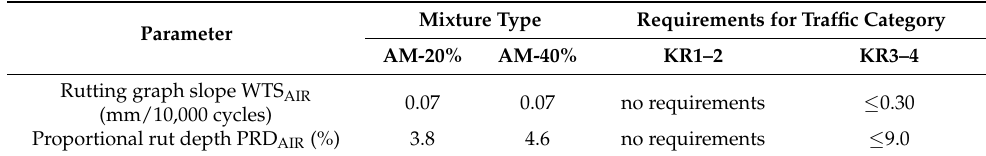
Table 6. The test results of the AMs resistance to durable deformations.